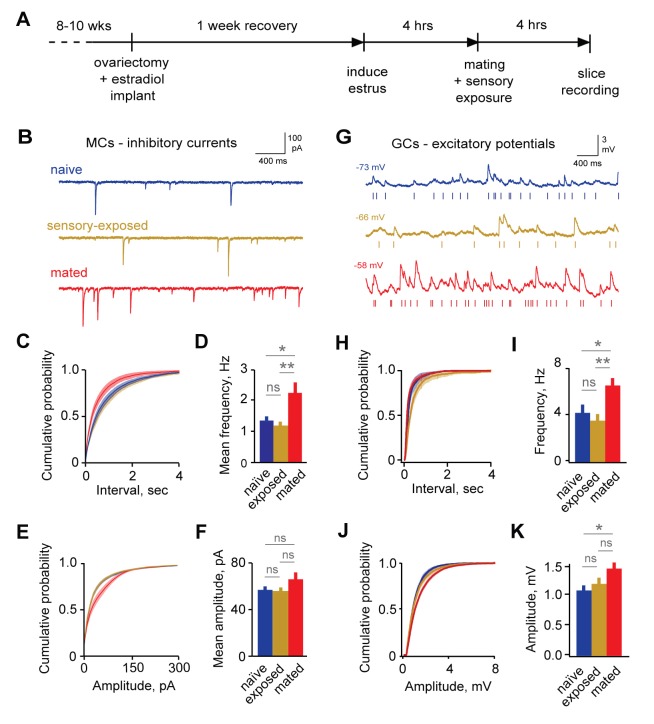
Imprinting drives synaptic plasticity in both MCs and GCs.(A) Schematic of timeline for mating, sensory experience, and recording. (B) Inhibitory synaptic inputs recorded in voltage-clamped MCs from naïve, sensory-exposed, and mated mice. (C,D) Mating substantially increases mIPSC frequency. Left, cumulative interval distributions; mated < naïve and exposed groups, p=0.002 and 0.001 respectively. Right, mean frequency (F = 5.88; Fc = 3.20; p=0.005 for mated vs. naïve; ANOVA with post-hoc Tukey test; n = 18, 17, and 15 cells in 5, 5, and 6 mice respectively). (E,F) The mean amplitude of mIPSCs was not significantly changed by imprinting (F = 1.74; Fc = 3.20; p=0.19; ANOVA with post-hoc Tukey test), although distributions were significantly shifted towards smaller values in the mated vs. naïve and sensory-exposed groups (p=0.00007 and 3 × 10−7 respectively. (G) Example traces showing spontaneous EPSPs in GCs from naïve, sensory-exposed and mated mice. Rasters indicate synaptic events used for analysis. (H,I) Mating increased mean sEPSP frequency relative to both naïve and sensory-exposed animals (F = 6.64; Fc = 3.14; p=0.00037 and 0.038 for mated vs. exposed and naïve mice respectively; ANOVA with post hoc Tukey test; n = 17, 19, and 30 cells in 5, 9, and 12 mice). Interval distributions were significantly smaller for mated vs. exposed and naïve animals (p=1×10−11 and 0.0008 respectively). (J,K) Mating also increased mean sEPSP amplitude in mated vs. naïve animals. Left, cumulative distribution; right, mean amplitude (F = 3.56; Fc = 3.14; p=0.037 for naïve vs. mated, ANOVA with post hoc Tukey test). Amplitude distributions were larger for mated vs. naïve mice (p=0.04). NS, not significant; *p<0.05; **p<0.001.DOI:
http://dx.doi.org/10.7554/eLife.25421.00610.7554/eLife.25421.007Figure 2—source data 1.This spreadsheet contains the mean frequency and amplitude data for the individual neurons used to generate the bar plots shown in Figure 2D and F (mitral cell mIPSCs) and 2I and 2K (granule cell mEPSCs).These data can be opened with Microsoft Excel or with open-source alternatives such as OpenOffice.